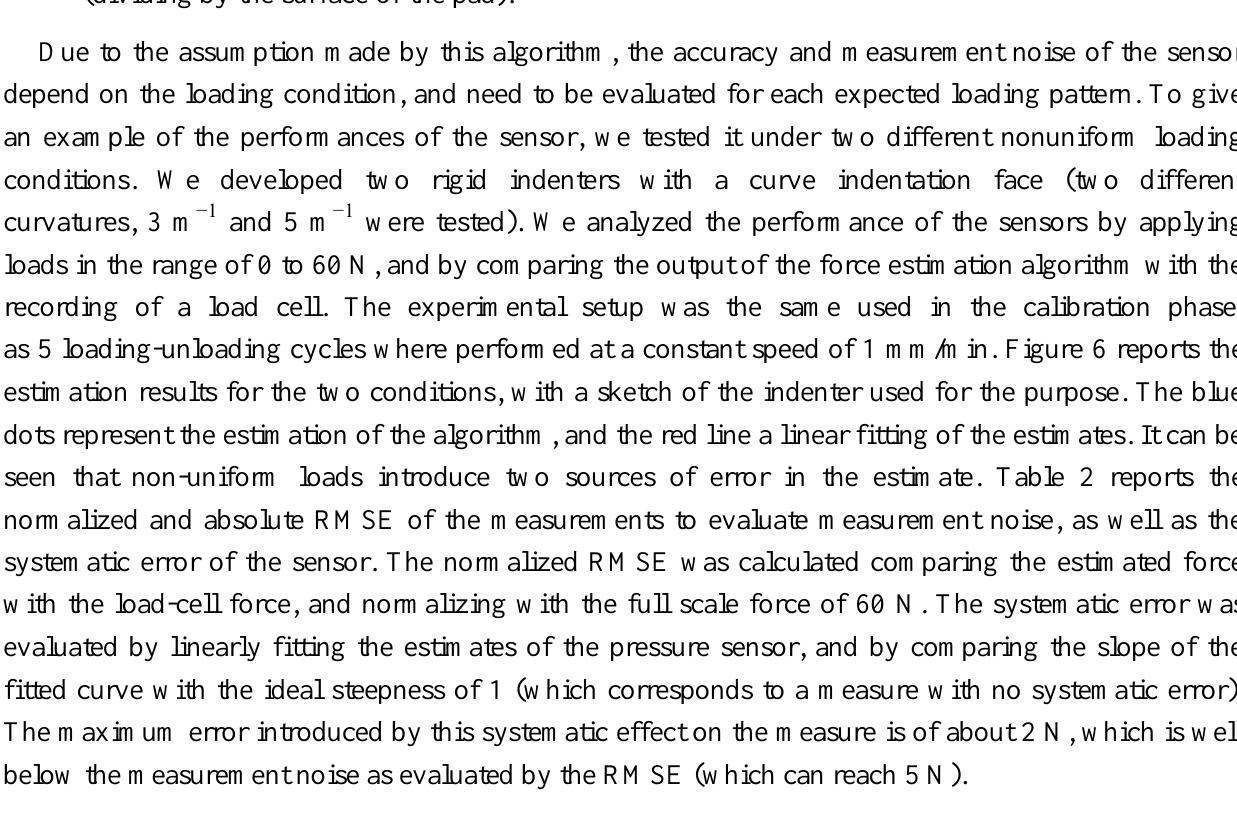
Figure 6. Force estimation results under non-uniform loading conditions (a) with a curvature of 3 m −1 , (b) with a curvature of 5 m −1